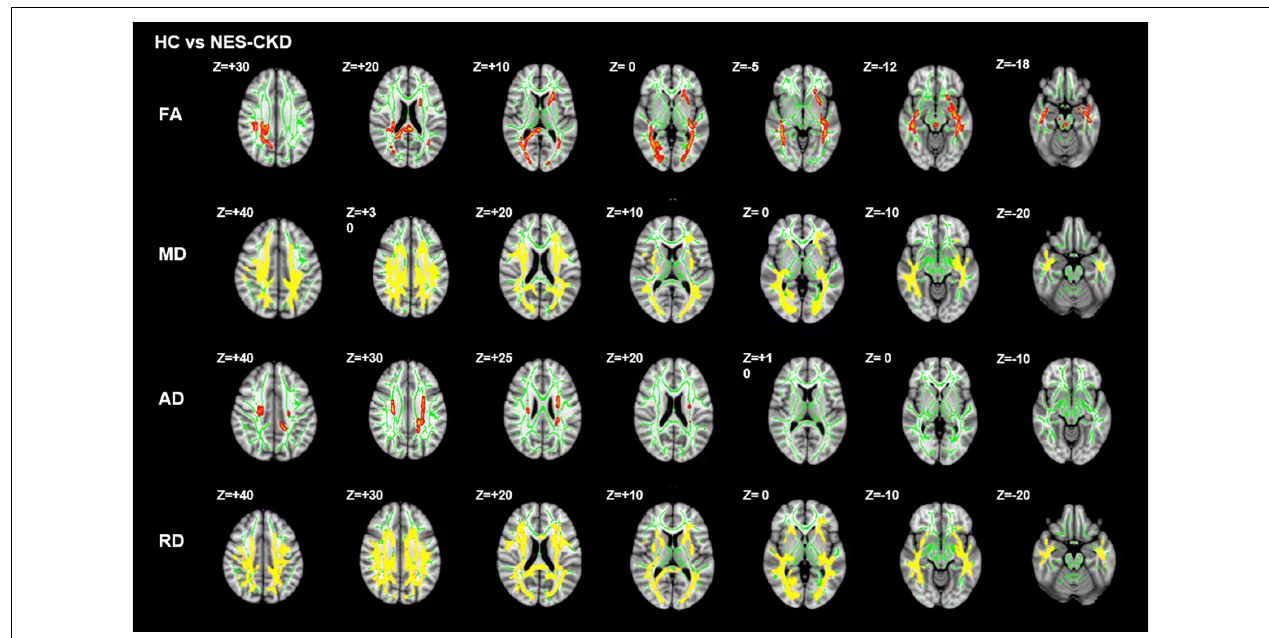
FIGURE 3 | Post hoc analyses result between patients with NES-CKD and HCs. Green represents the mean FA skeleton of all subjects. Red–yellow represent regions with significant statistical values ( p < 0.05, TFCE-corrected). NES-CKD, non-end-stage chronic kidney disease; HC, healthy control; FA, fractional anisotropy; MD, mean diffusivity; AD, axial diffusivity; RD, radial diffusivity.